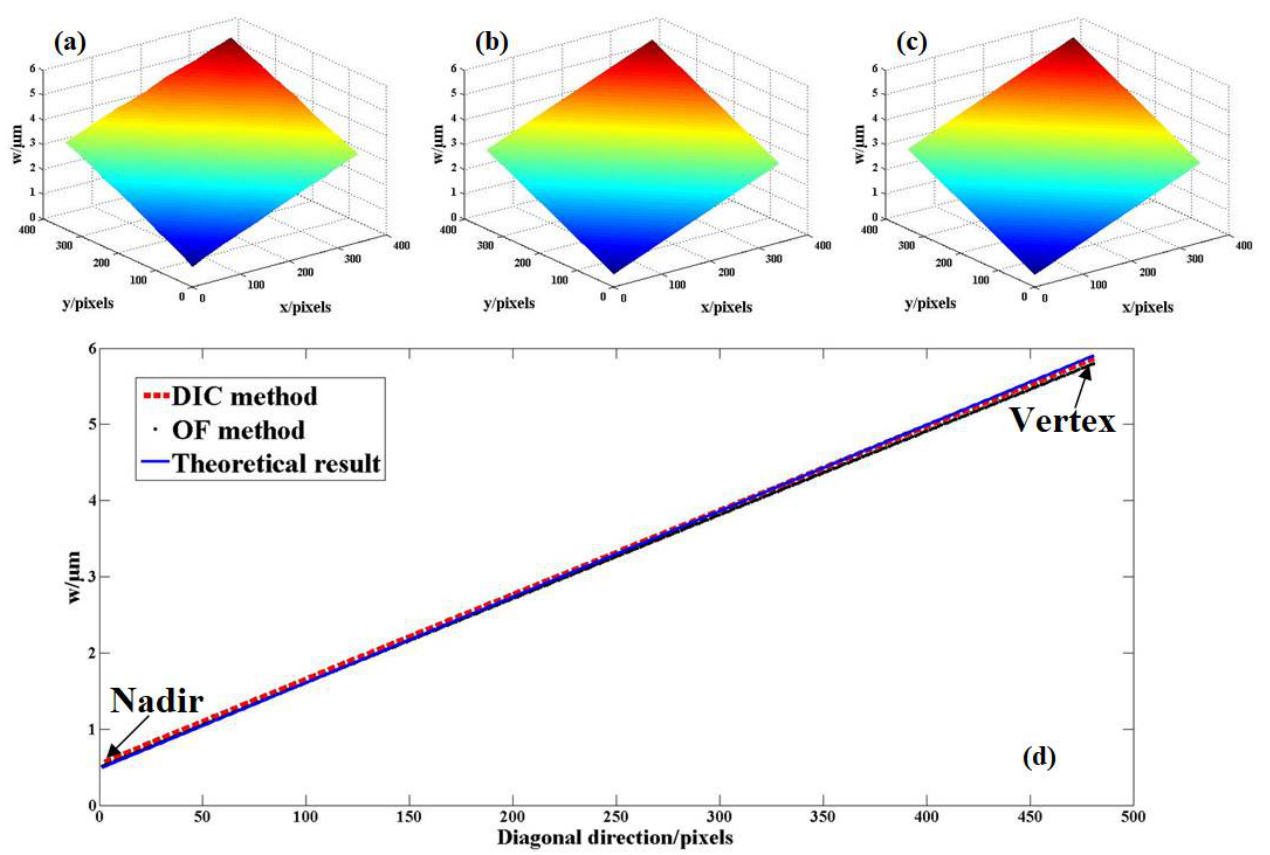
Figure 11. Out-of-plane displacement results of application experiment: ( a ) field w (DIC method); ( b ) field w (OF method); ( c ) field w (theoretical result); ( d ) data of ( a – c ) in diagonal direction. Table 2. Data of vertex and nadir in Figure 11d.